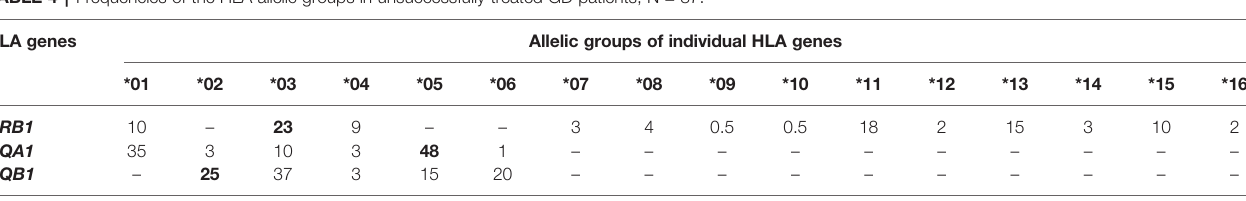
TABLE 4 | Frequencies of the HLA allelic groups in unsuccessfully treated GD patients, N = 87. HLA genes